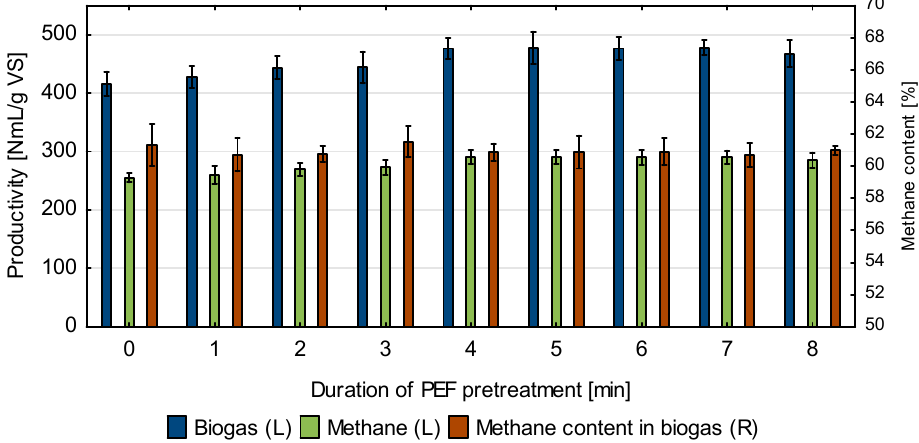
Figure 7. Biogas production, methane production and methane content in biogas after PEF pre- treatment. Table 2. Kinetic parameters of methane production from PEF-pre-treated substrate, as determined from the first-order model.